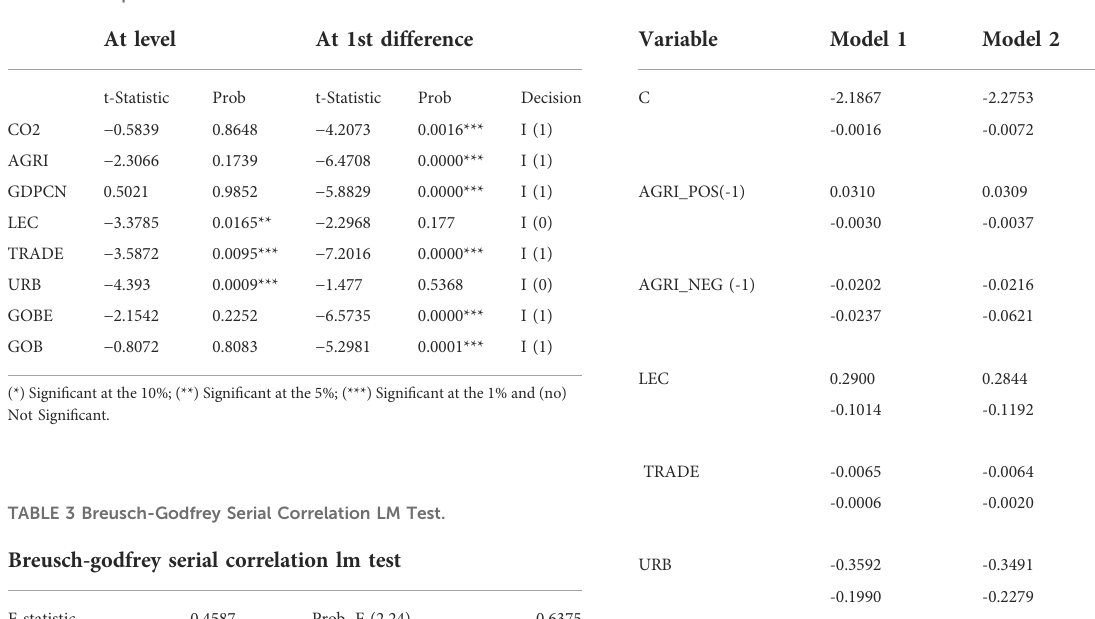
TABLE 4 Short run